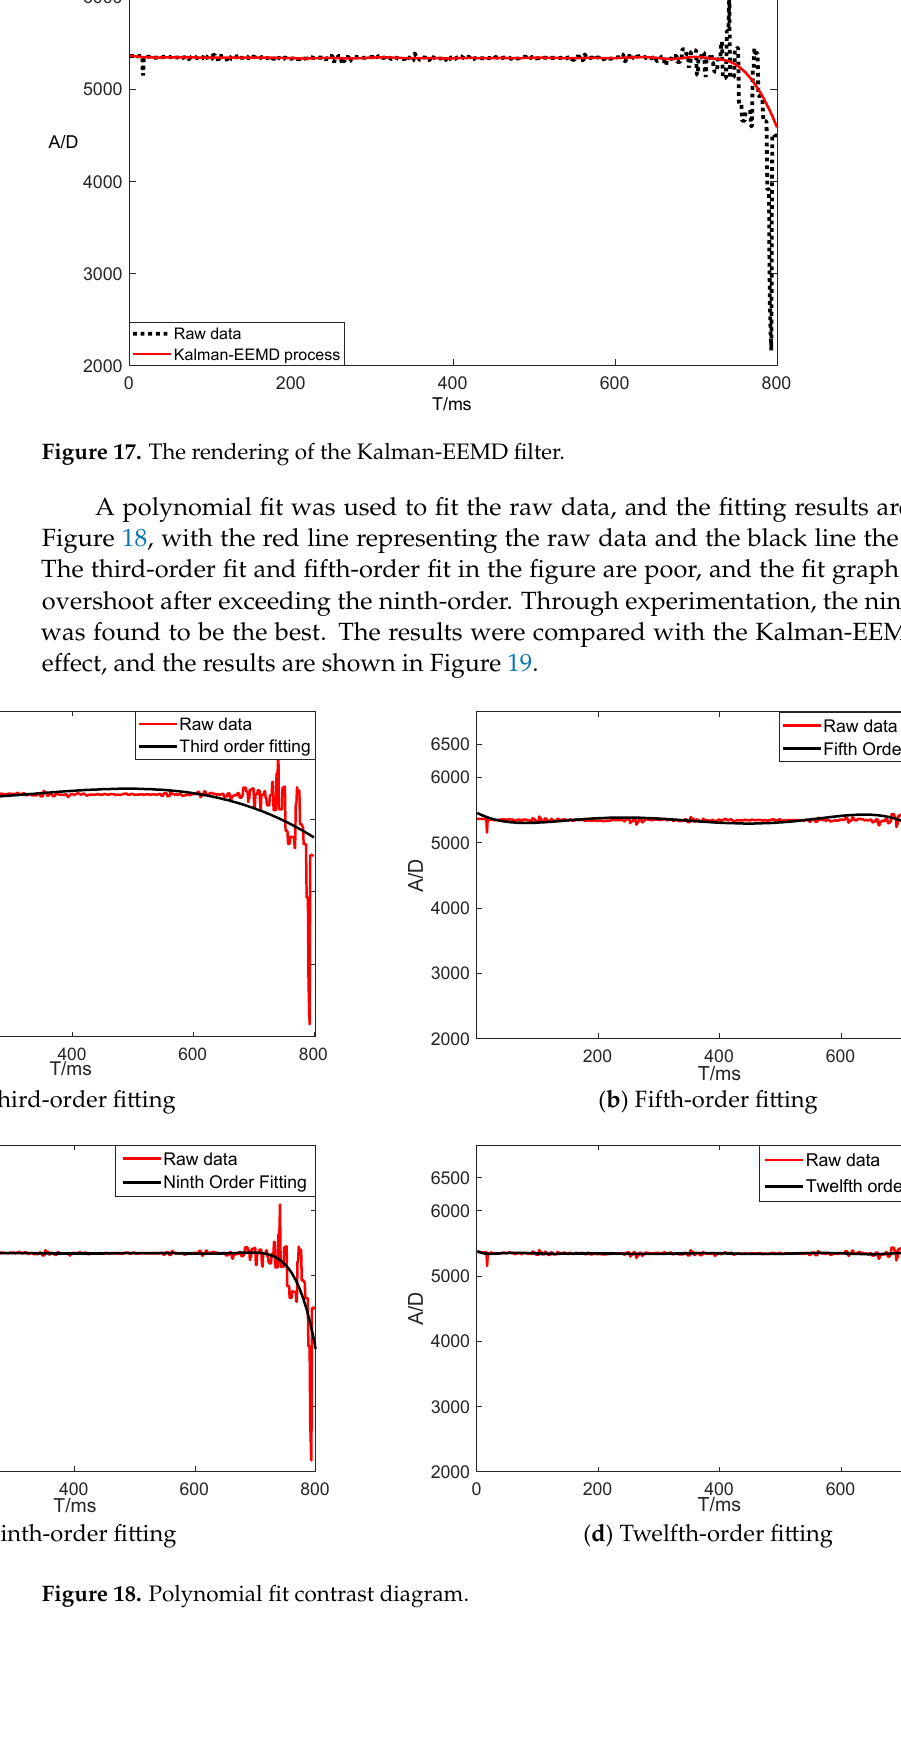
Figure 19. Comparison of the ninth-order fi tt ing and Kalman-EEMD fi ltering e ff ect. In Figure 19, the black line is the data processed by the Kalman-EEMD fi ltering algo- rithm, and the red line is the data after the ninth-order fi t. The fi tt ing function is 𝑓(𝑥) = 𝑝1 × 𝑥 (cid:2877) + 𝑝2 × 𝑥 (cid:2876) + 𝑝3 × 𝑥 (cid:2875) + 𝑝4 × 𝑥 (cid:2874) + 𝑝5 × 𝑥 (cid:2873) + 𝑝6 × 𝑥 (cid:2872) + 𝑝7 × 𝑥 (cid:2871) + 𝑝8 × 𝑥 (cid:2870) + 𝑝9 × 𝑥 + 𝑝10 (14) where p 1 = − 1.54 × 10 − 20 , p 2 = 4.935 × 10 − 17 , p 3 = − 6.615 × 10 − 14 , p 4 = 4.81 × 10 − 11 , p 5 = − 2.057 × 10 − 8 , p 6 = 5.246 × 10 − 6 , p 7 = − 0.0007712, p 8 = 0.05986, p 9 = − 2.08, and p 10 = 5367. In compari- son, the Kalman-EEMD fi ltering algorithm in the horizontal region achieved the desired fi ltering e ff ect; the Kalman-EEMD fi ltering algorithm was be tt er than the ninth-order best fi t because the ninth-order fi t showed an overshoot at the horizontal coordinate 700.